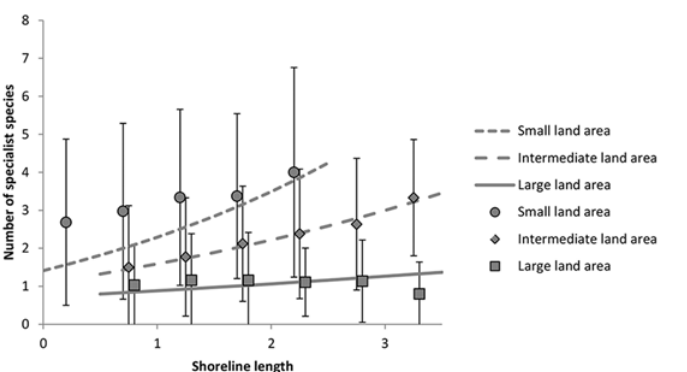
Fig 3. Interaction of shoreline length and land area on number of coastal specialist species per square. Lines show modelled interaction (see Fig. 2) for different levels of land area; data points (mean values ± 1 standard deviation) show empirical estimates for land area ranges of 0 – 0.49, 0.5 – 0.99, 1 – 1.49 and so forth. Both shoreline length and land area were mean standardised.